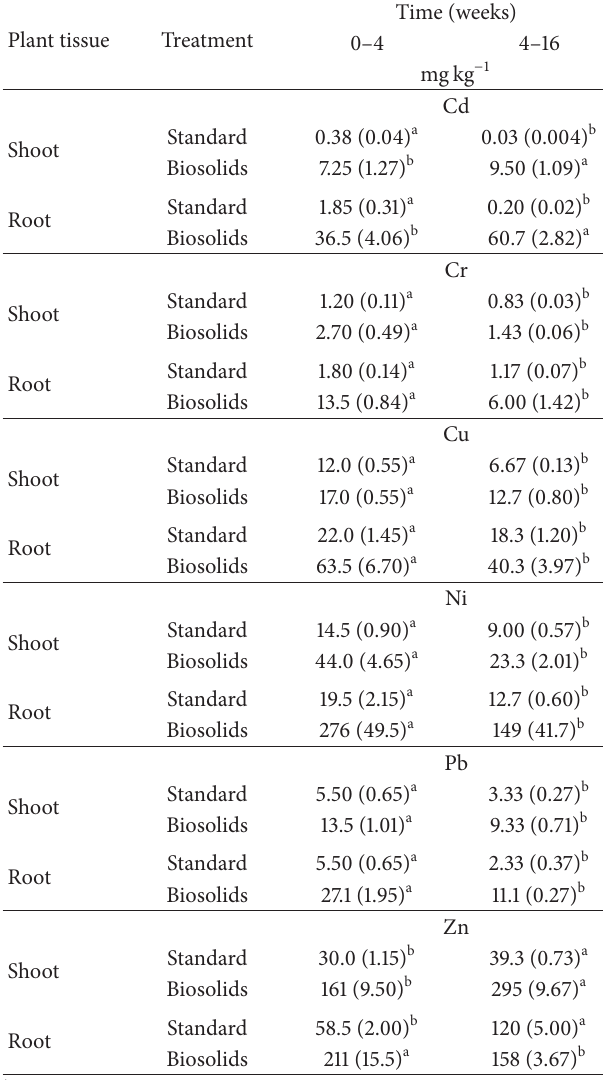
Table 1: Metal concentrations (means ± SD where 𝑛 = 4 ) of corn tissuesgrownonsandmediaamended,withoutbiosolids(Standard) and with biosolids †